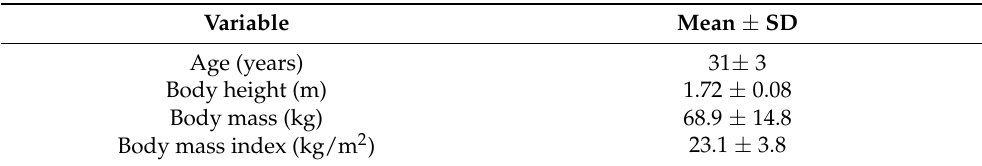
Table 1. Anthropometric characteristics of the